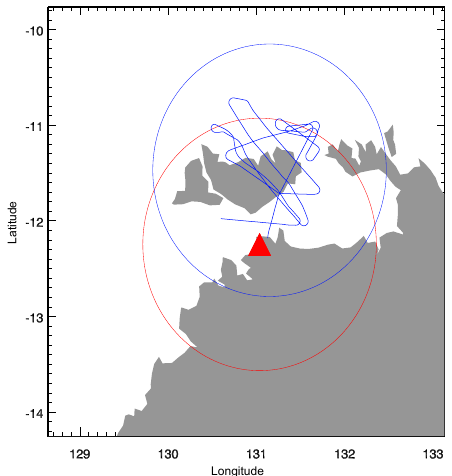
Figure 1. 1km simulation domain with the radar location denoted by the red triangle and the 150km range of the radar shown by the red circle. The aircraft flight track is shown by the blue line with the domain used in the aircraft comparison given by the blue